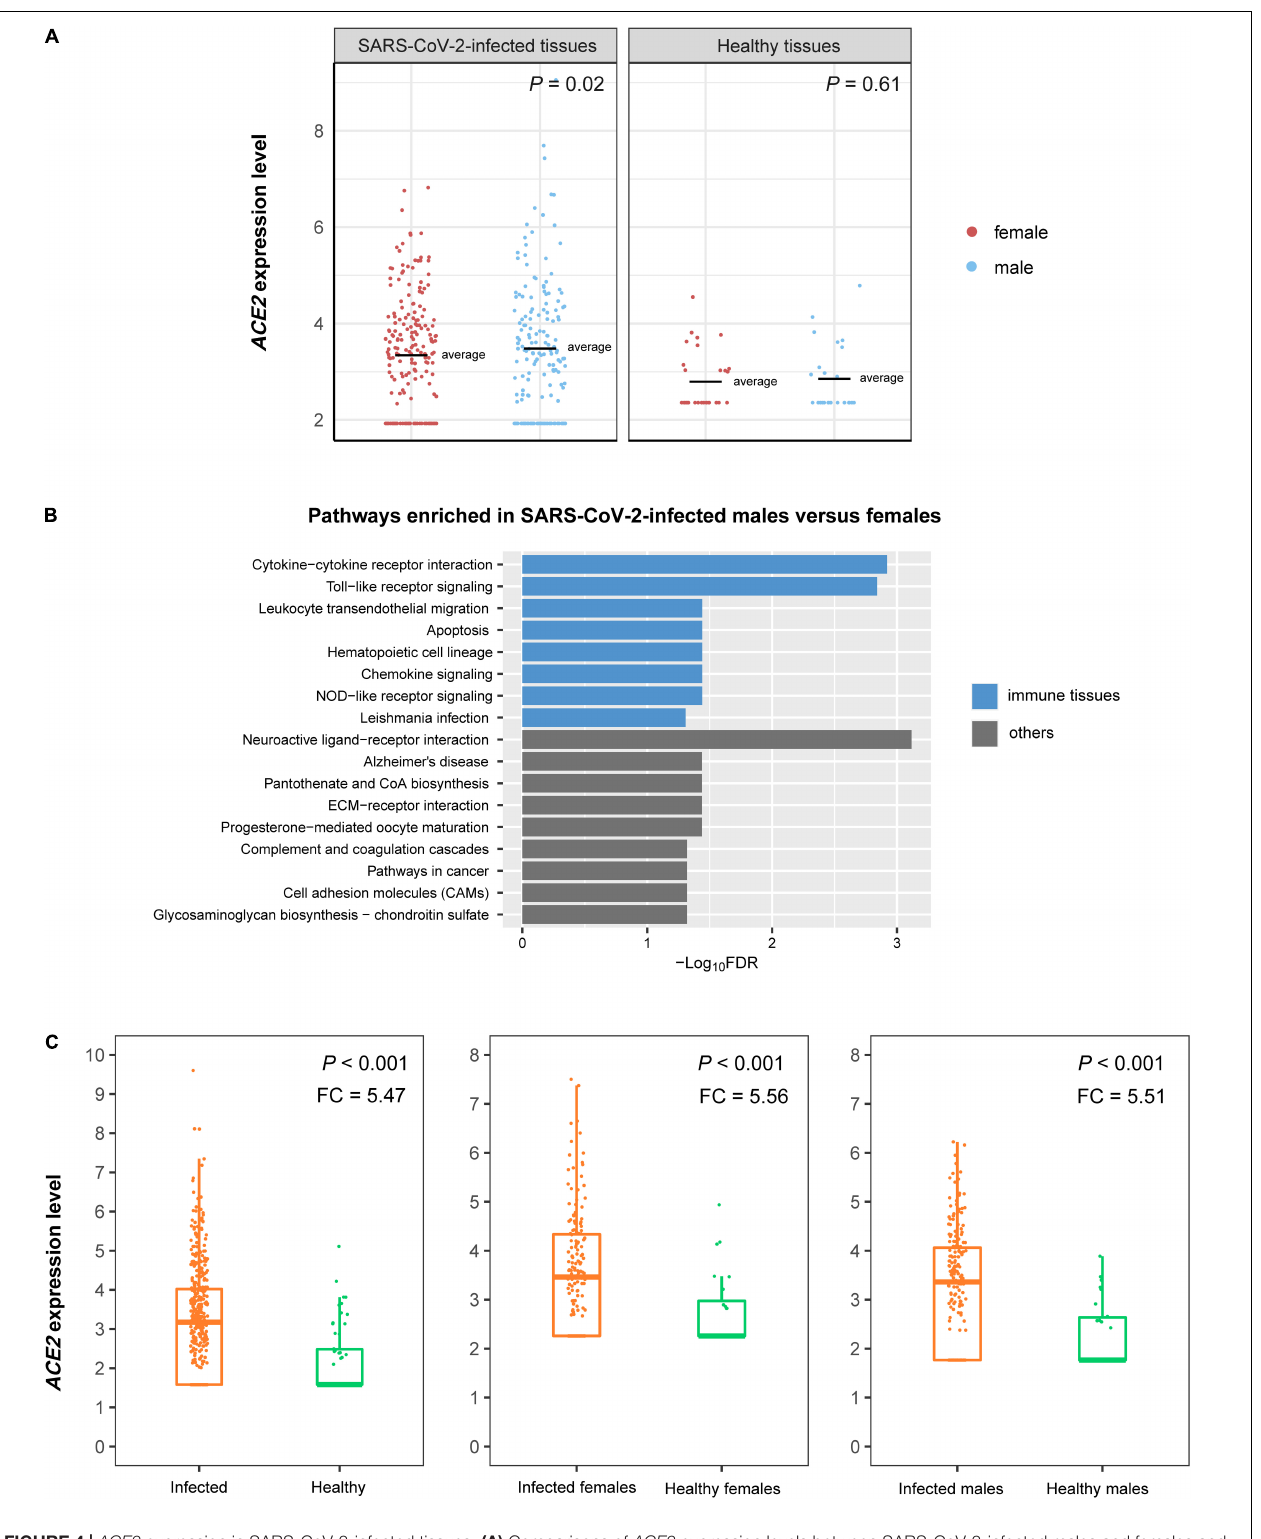
FIGURE 4 | ACE2 expression in SARS-CoV-2-infected tissues. (A) Comparisons of ACE2 expression levels between SARS-CoV-2-infected males and females and between healthy males and females. (B) KEGG pathways highly enriched in SARS-CoV-2-infected males relative to females identified by GSEA (Subramanian et al., 2005). The immune-related pathways are highlighted in blue. (C) Comparisons of ACE2 expression levels between SARS-CoV-2-infected and normal tissues. FC: fold change of mean ACE2 expression